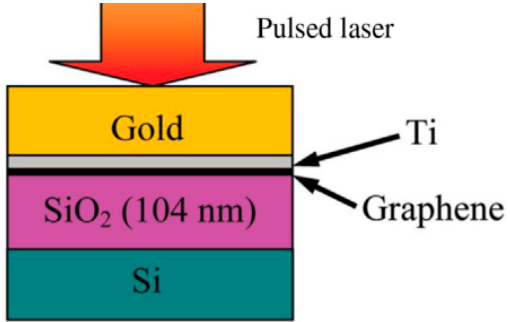
Figure 8. Time-domain thermoreflectance diagram (TDTR) [125]. Reprinted with permission from ref. [125]. Copyright 2003 American Chemical Society.